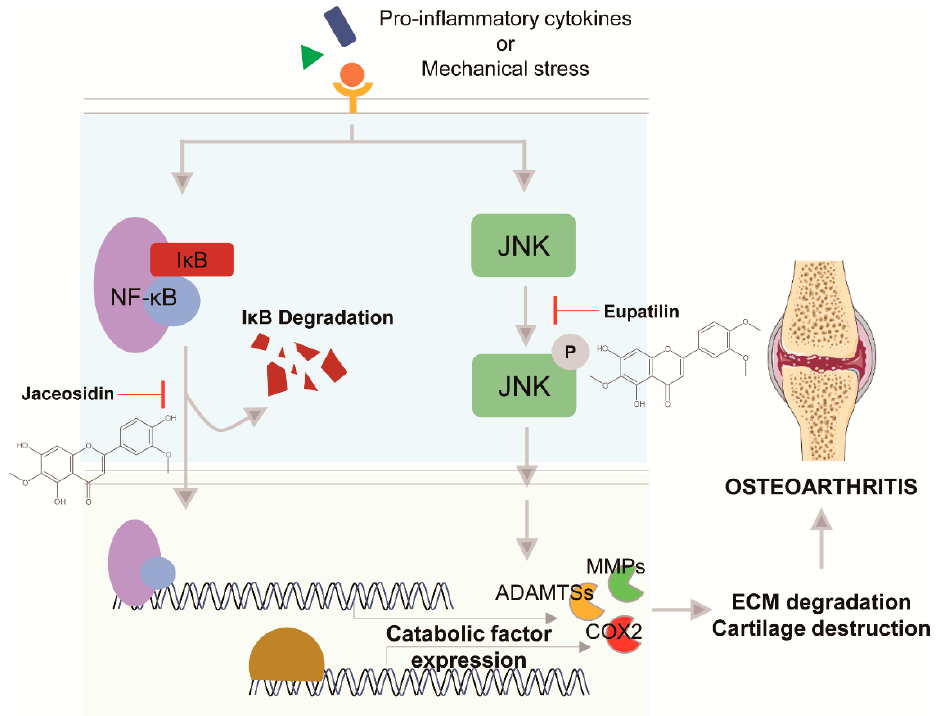
Figure 3. Mechanism of action of jaceosidin and eupatilin.